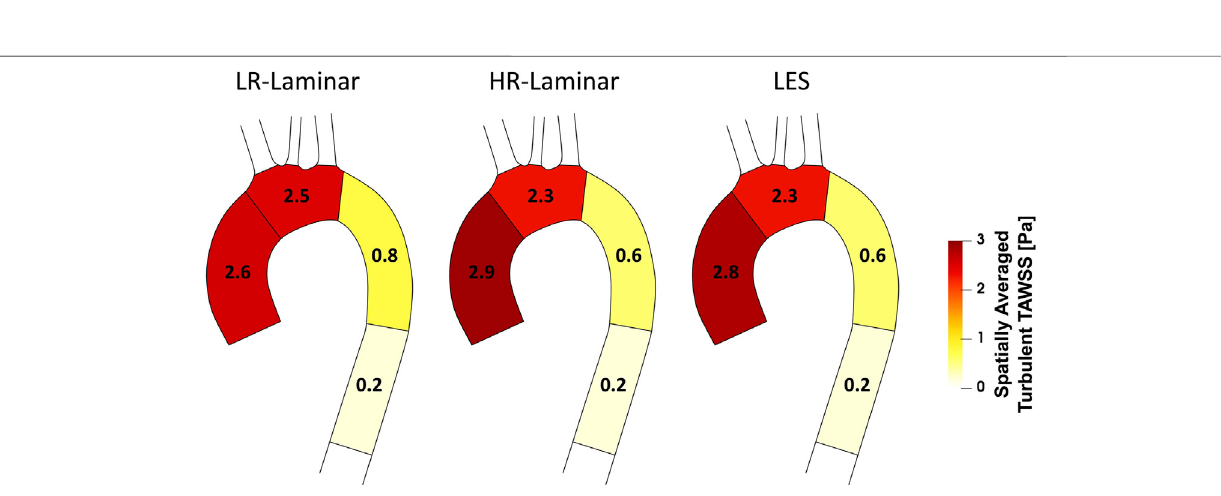
FIGURE 9 | Regional analysis visualisation. Time-averaged turbulent wall shear stress (Turbulent-TAWSS) spatially averaged over regions of interest for LR- Laminar, HR-Laminar and LES